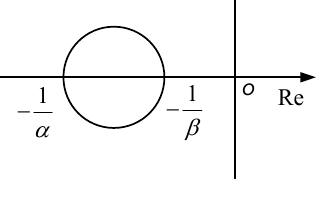
Fig. 17. Illustration of disk